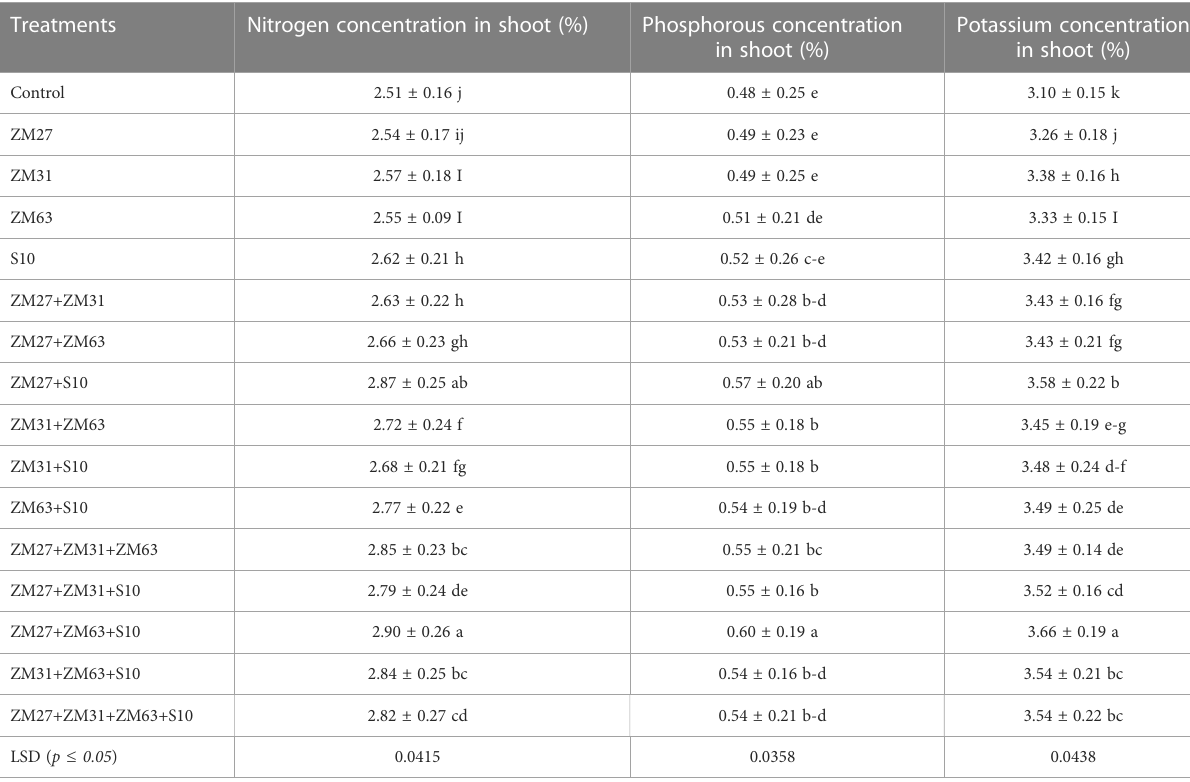
TABLE 2 Effect of novel bio inoculants on root dry biomass and macronutrients contents of maize in the pot trial.